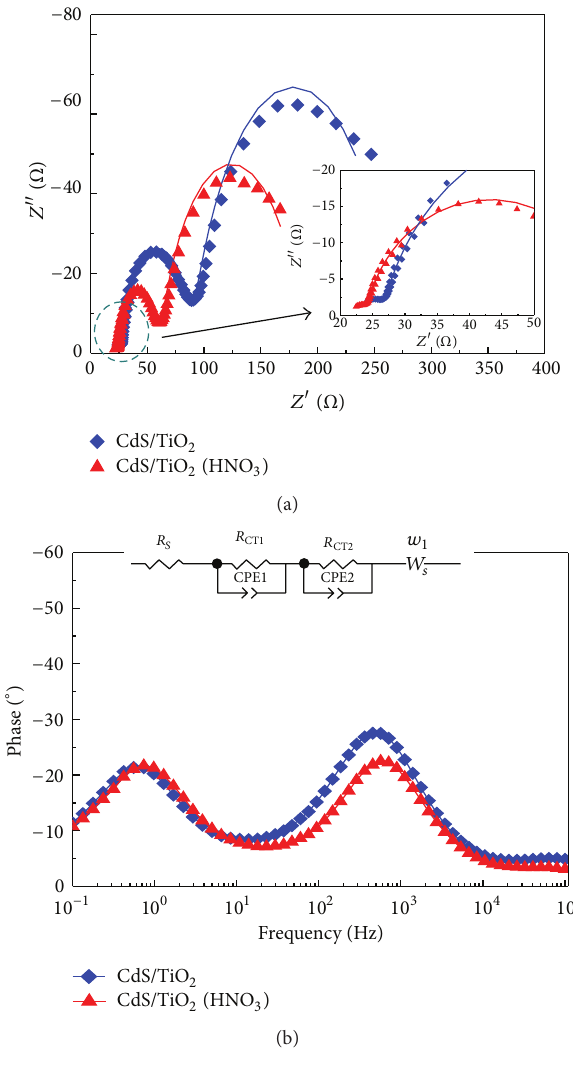
Figure 7: Electrochemical impedance spectra of CdS-sensitized solar cells: (a) Nyquist plots and (b) Bode plots.